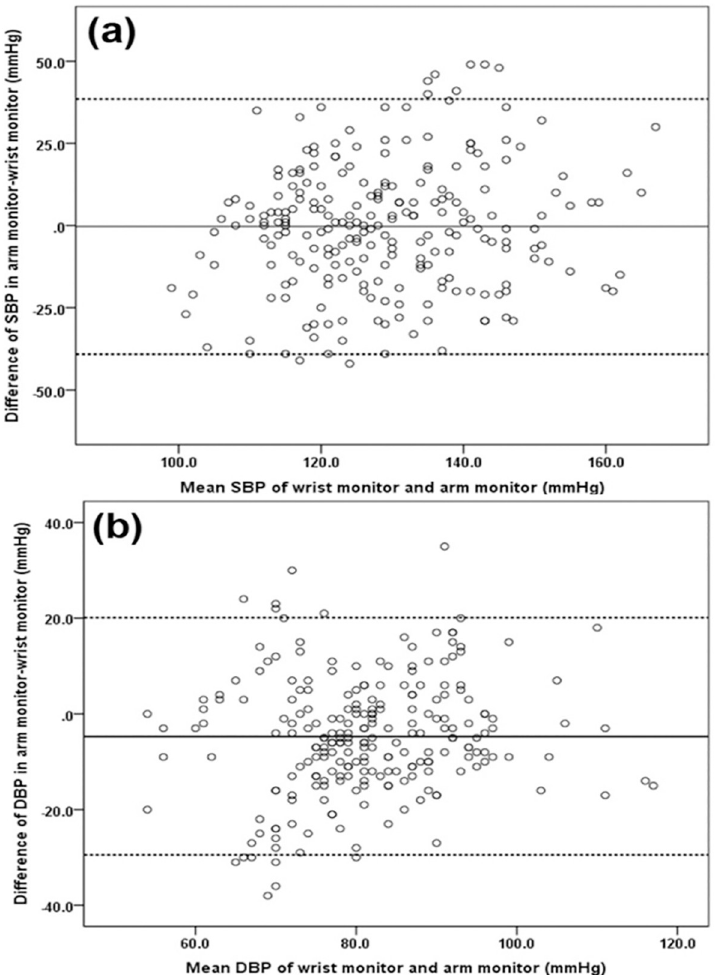
Fig 2. Bland–Altman plots presenting the mean and the difference in blood pressure measurements (mmHg) between the wrist and arm monitors for sleeping SBP (a) and sleeping DBP (b). The solid black horizontal line represents the mean difference and the dotted horizontal lines represent 2SD above and below the mean. There was a mean difference of -0.3 mmHg and a 2SD difference between the arm monitor and the wrist monitor of -39.1to 38.5 mmHg in SBP and a mean difference of -4.7 mmHg and a 2SD difference of -29.5 to 20.1 mmHg in DBP. DBP = diastolic blood pressure, SBP = systolic blood